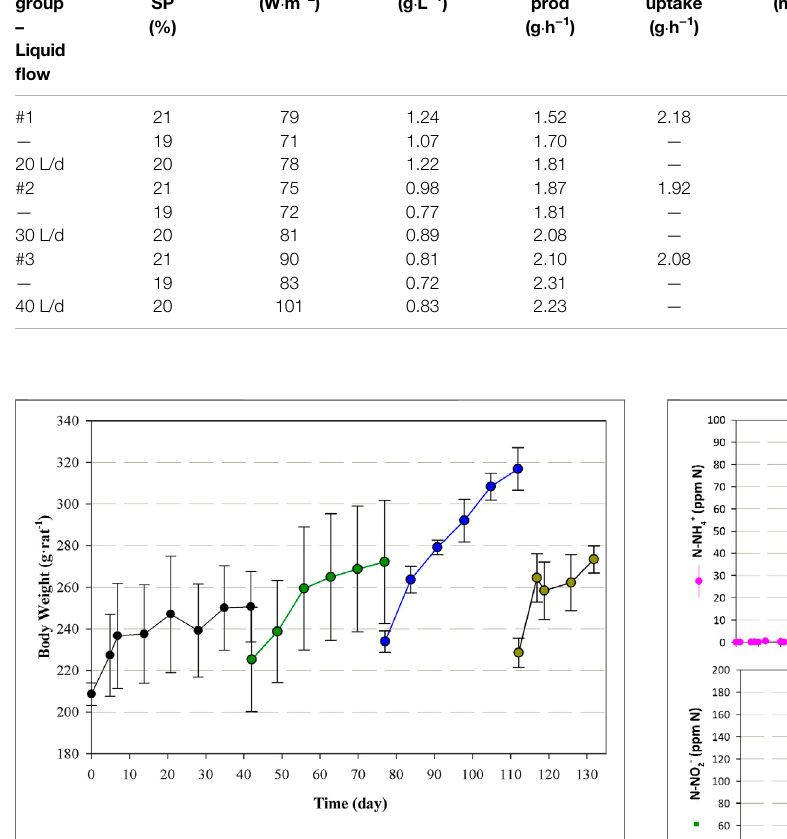
FIGURE 8 | Body weight for each group of rats ( fi rst: black; second: green; third: blue) during their corresponding experimental period. The last group of rats (brown) corresponds to the control group.